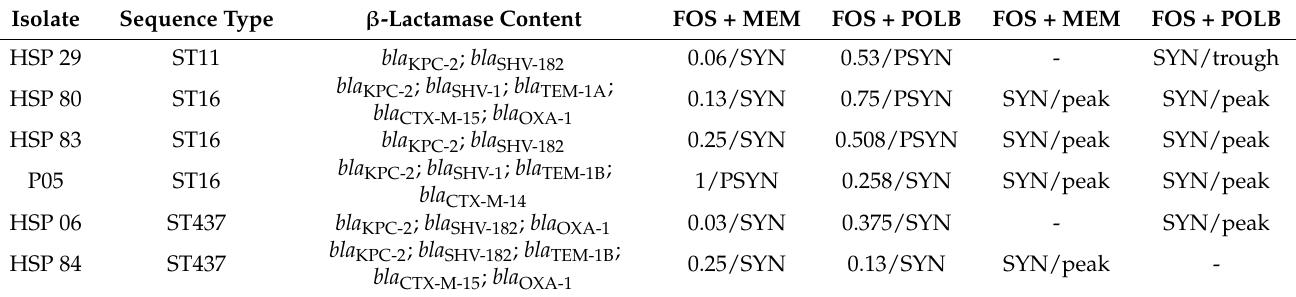
Table 4. Comparison between CKA and TKA.